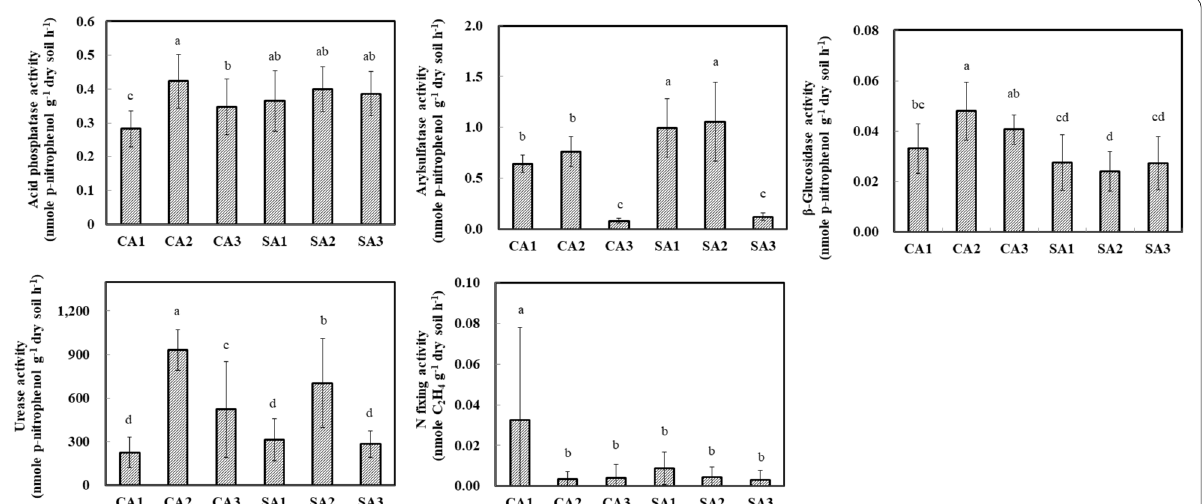
Fig. 2 Temporal variations in the soil enzymatic activities of litchi orchards that were maintained under conventional (CA) and sustainable (SA) agricultural practices. 1, 2 and 3 indicate successive trimester samplings carried out on October 2016, January 2017 and April 2017, respectively. Acid phosphatase, arylsulfatase, and β‑glucosidase activities were analyzed by the p ‑nitrophenol method. The N 2 ‑fixing activity was detected by the acetylene reduction method using gas chromatography. Results are shown as mean